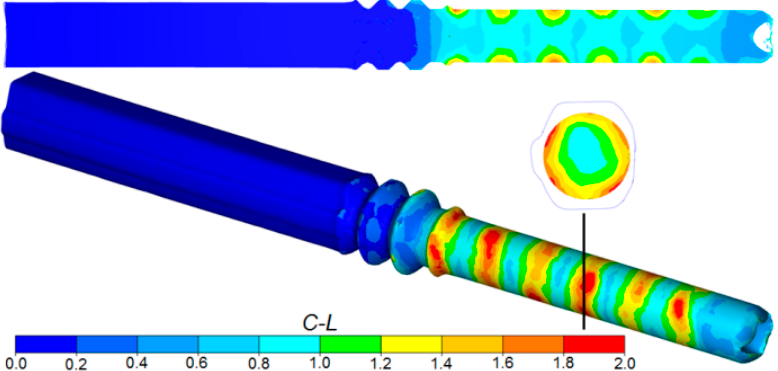
Figure 10. FEM distribution of the Cockroft–Latham damage criterion during rolling of rods in the helical pass of the skew rolling mill.